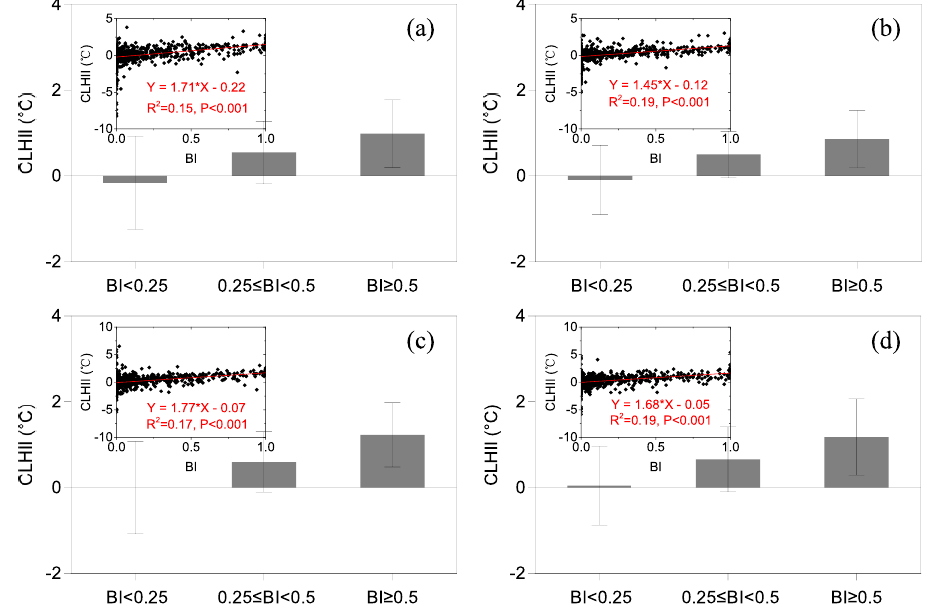
Figure 8. Relationships of CLHII with BI. The average of seasonal CLHII is shown for different BI bins (mean ± standard deviation). The insets show the correlation between CLHII and BI intensity. CLHII in ( a ) spring, ( b ) summer, ( c ) autumn, and ( d ) winter for different BI binned into 0.25 intervals. The red line is the linear regression line.